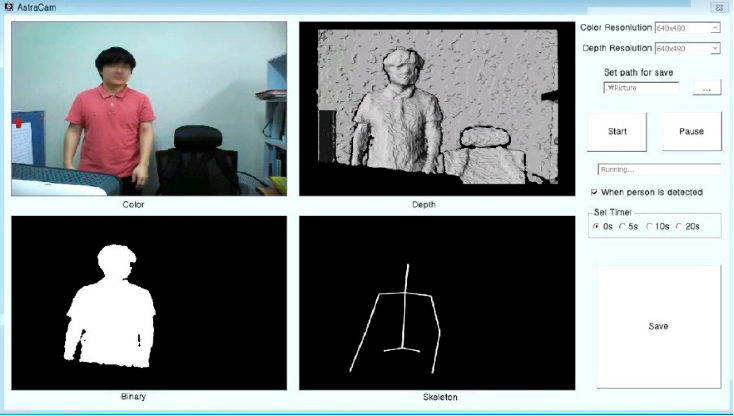
Figure 8. Graphical user interface (GUI) for constructing the posture database.